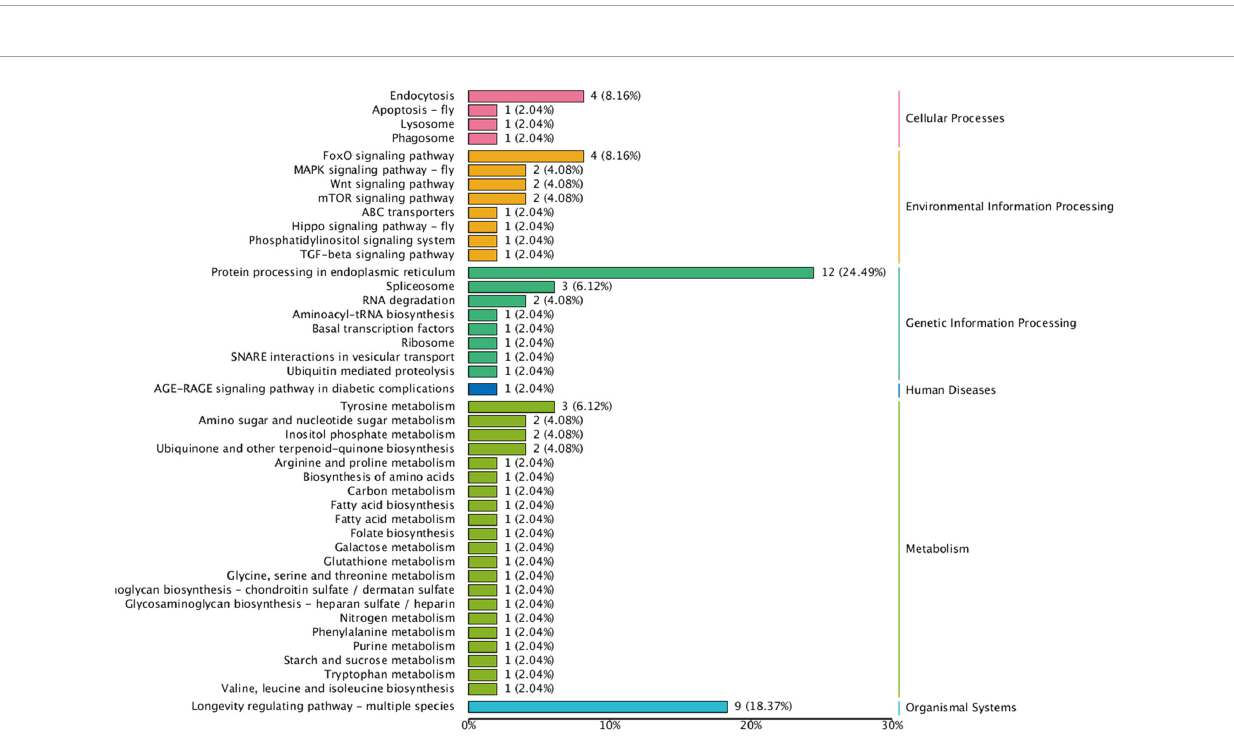
FIGURE5 Kyoto Encyclopedia of Genes and Genomes (KEGG) pathway enrichment analysis of DEGs. The Y -axis indicates the pathway and the X -axis indicates the number of annotated genes.